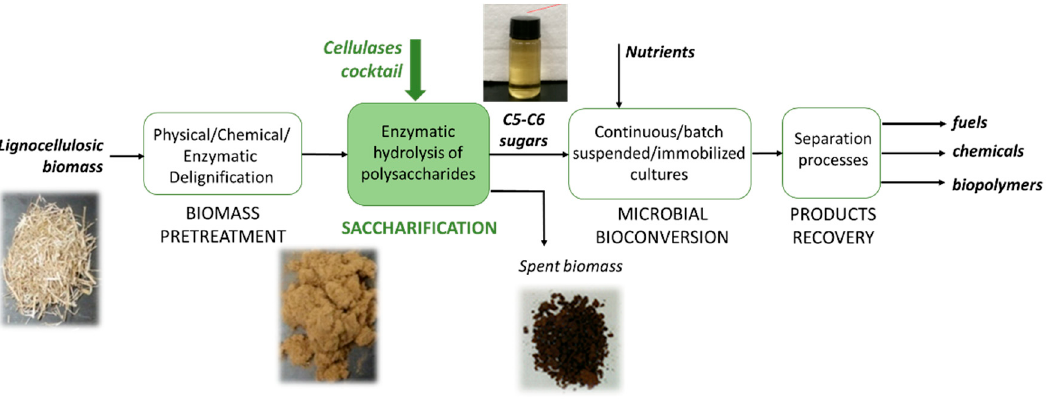
Figure 1. Block diagram of a sugar-based biorefinery.